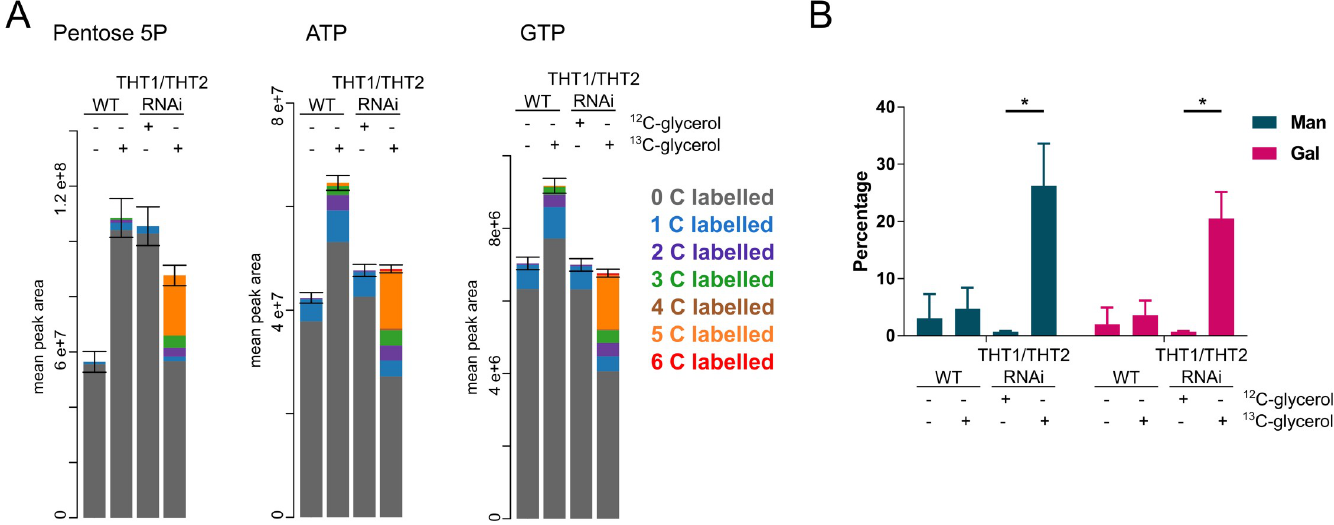
Fig 5. Carbons from glycerol are incorporated into PPP intermediates and VSG glycans. (A) 13 C from glycerol is incorporated into PPP intermediates, such as pentose 5-phosphate which is further used for ATP and GTP synthesis. The samples and visualization are as in Fig 4B. (B) VSG was purified from wild-type and THT1/ THT2 RNAi knockdown parasites grown with and without 13 C glycerol, as indicated, and subjected to monosaccharide compositional analysis by GC-MS. Following correction for natural isotope abundance, the proportion of VSG-derived mannose and galactose residues containing 13 C carbon from glycerol were determined. For all analyses, n = 3; � p < 0.0001, Student’s t